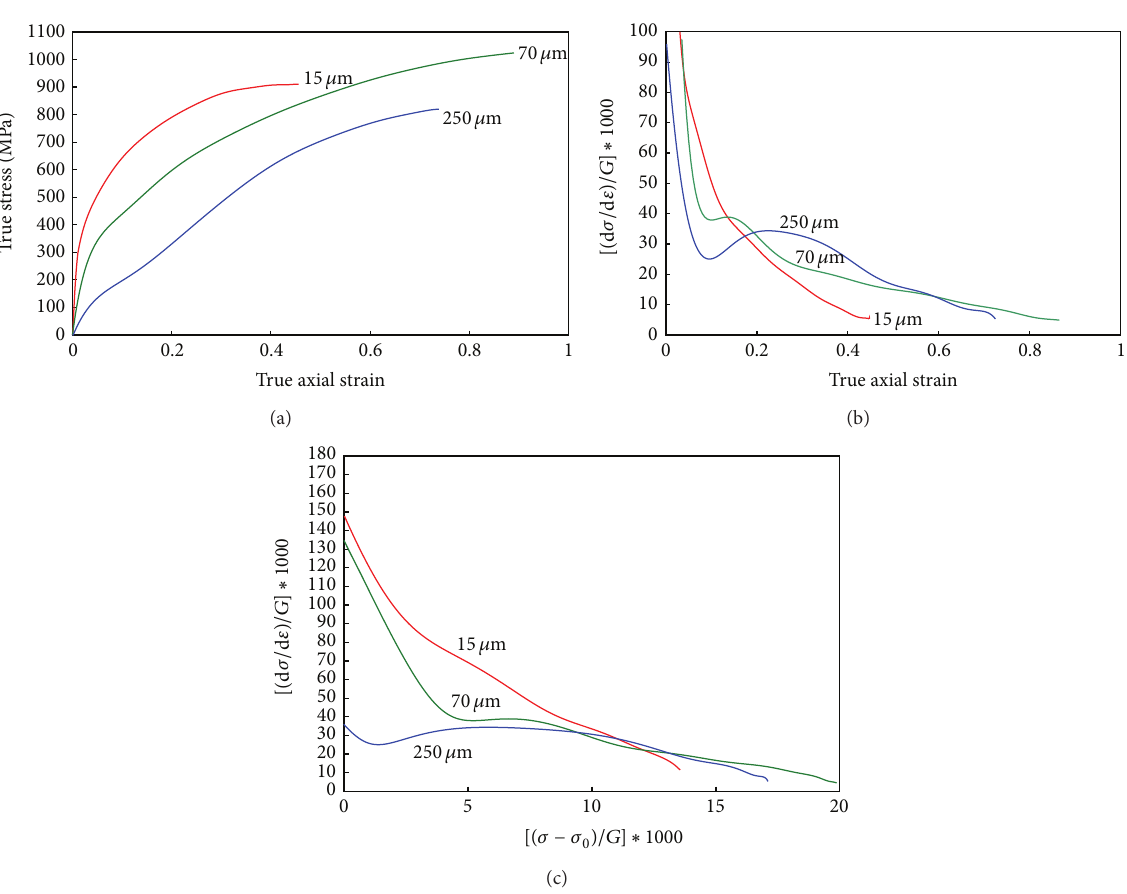
Figure 5: (a) True stress-true strain response for Cu-7Al for all three grain sizes, tested in plane strain compression. Normalized strain hardening rate versus true strain in (b) and versus normalized stress parameter in (c) for all materials displayed in part